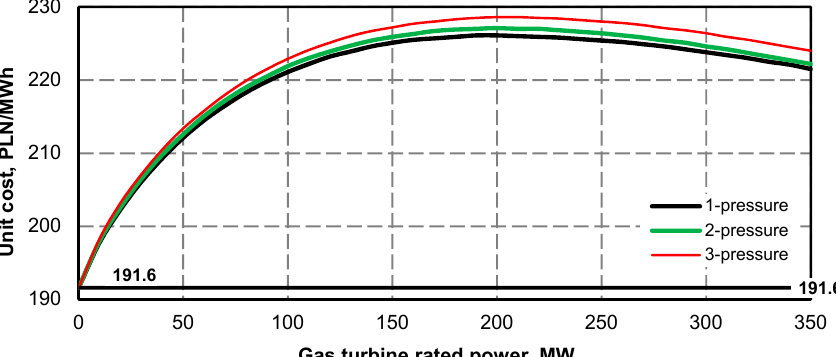
Figure 45 . Unit generation cost for electric power as a function of gas turbine rated power for operating it with 60% of rated power and various structures of recovery boiler ( e c = 9.52 PLN / GJ, e g = 22 PLN / GJ, (k el ) ex = 170 PLN / MWh).